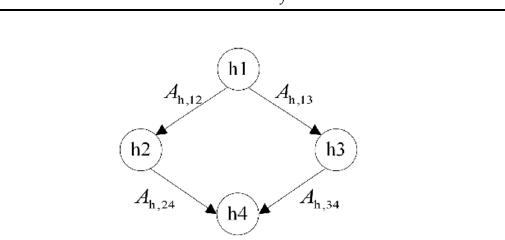
Figure 5. Diagram of the state transfer for hot backup.